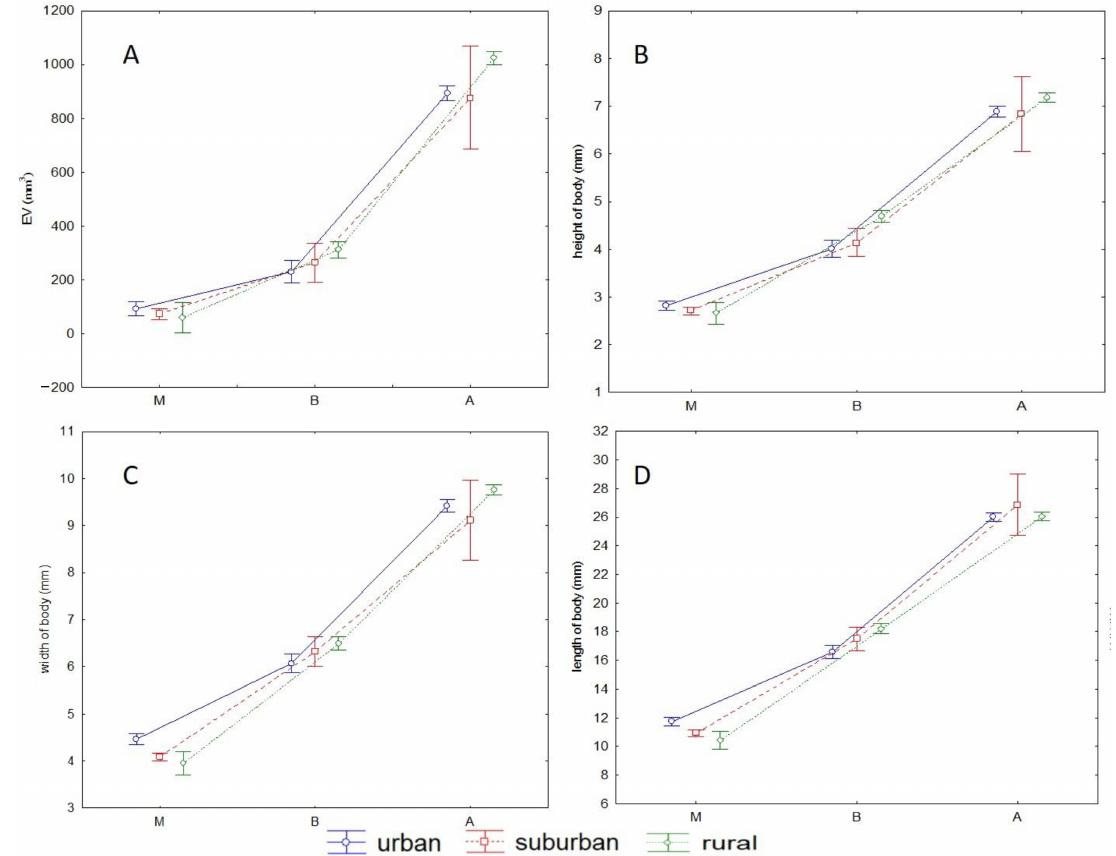
Figure 3. Average EV values ( A ), height of the body ( B ), length of the body ( C ), width of the body ( D ) of carabid species with di ff erent flight ability. Notes: M = macropterous, B = brachypterous, A = apterous. Vertical lines denote ± 95%